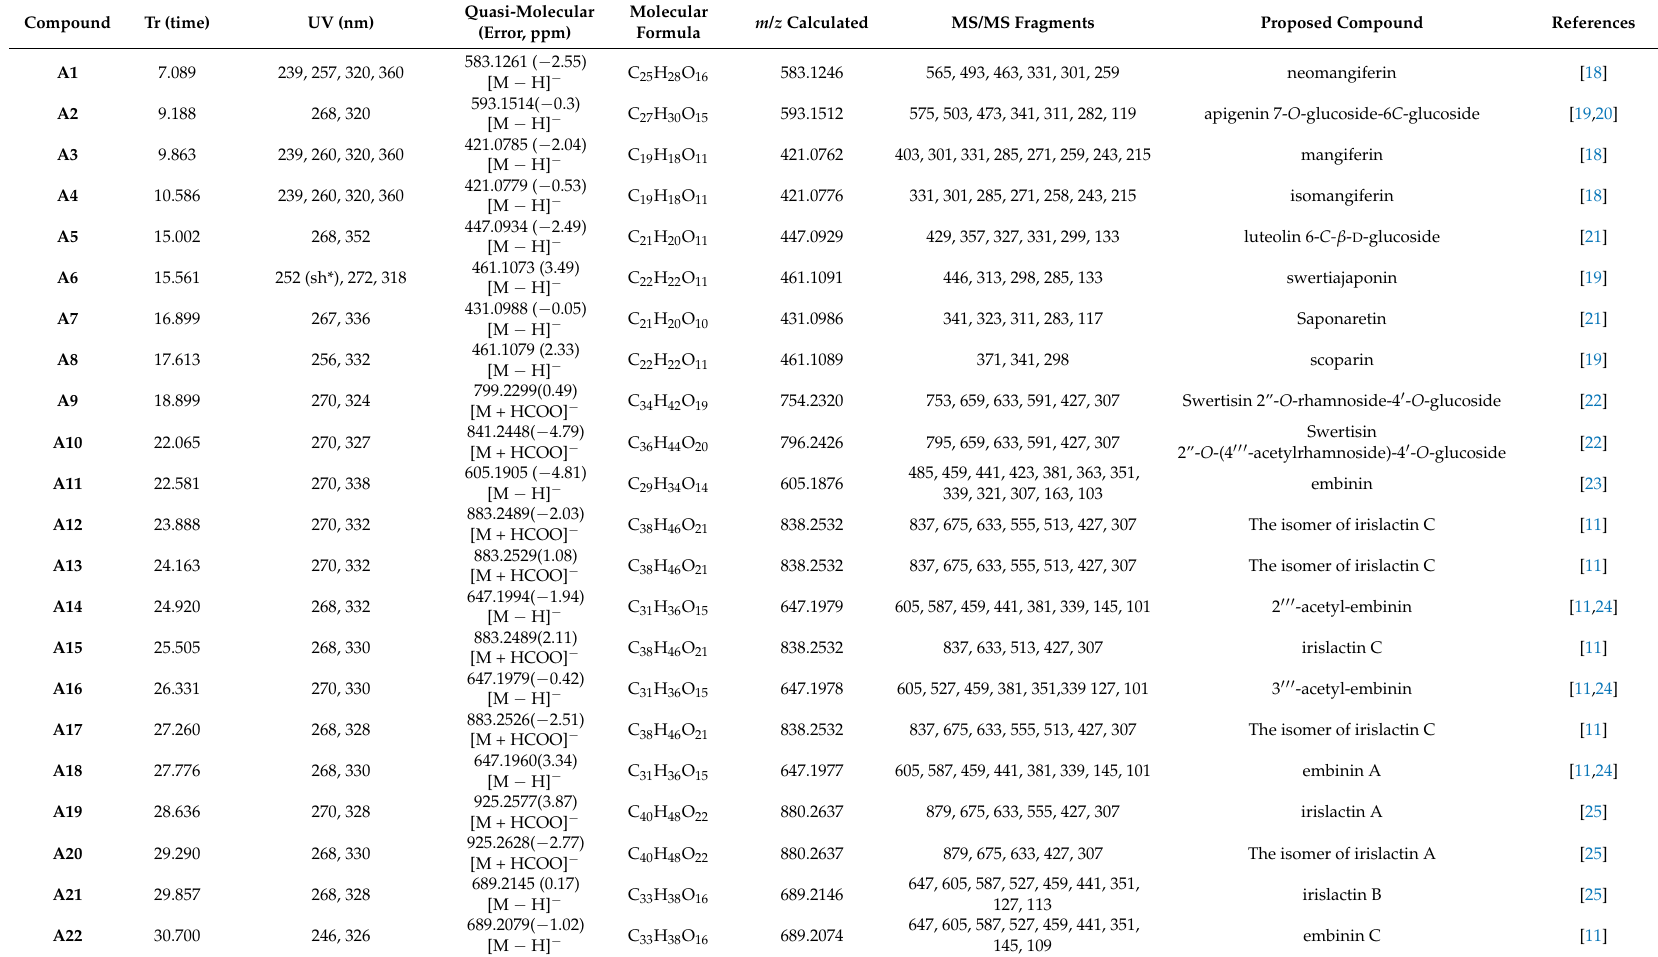
Table 1. Characterization of chemical constituents of Iris lactea by